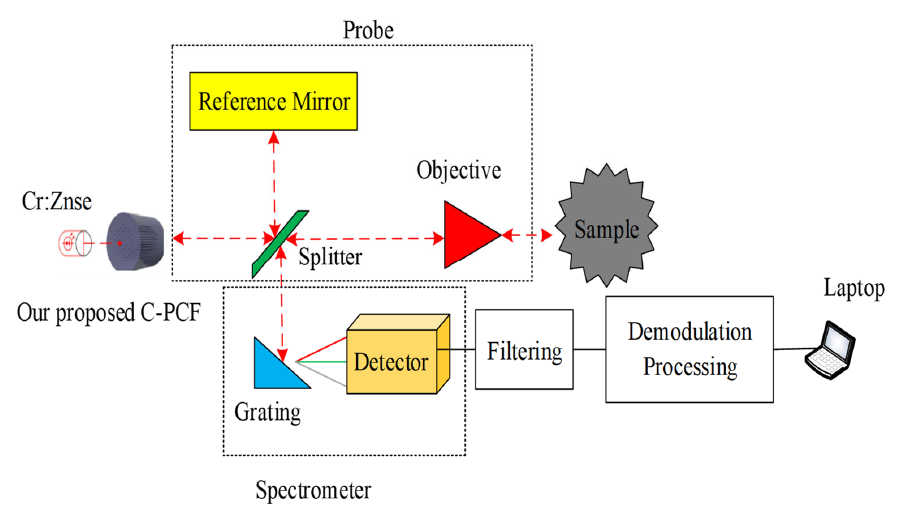
Figure 6. The proposed Mid ‐ IR OCT ‐ setup.